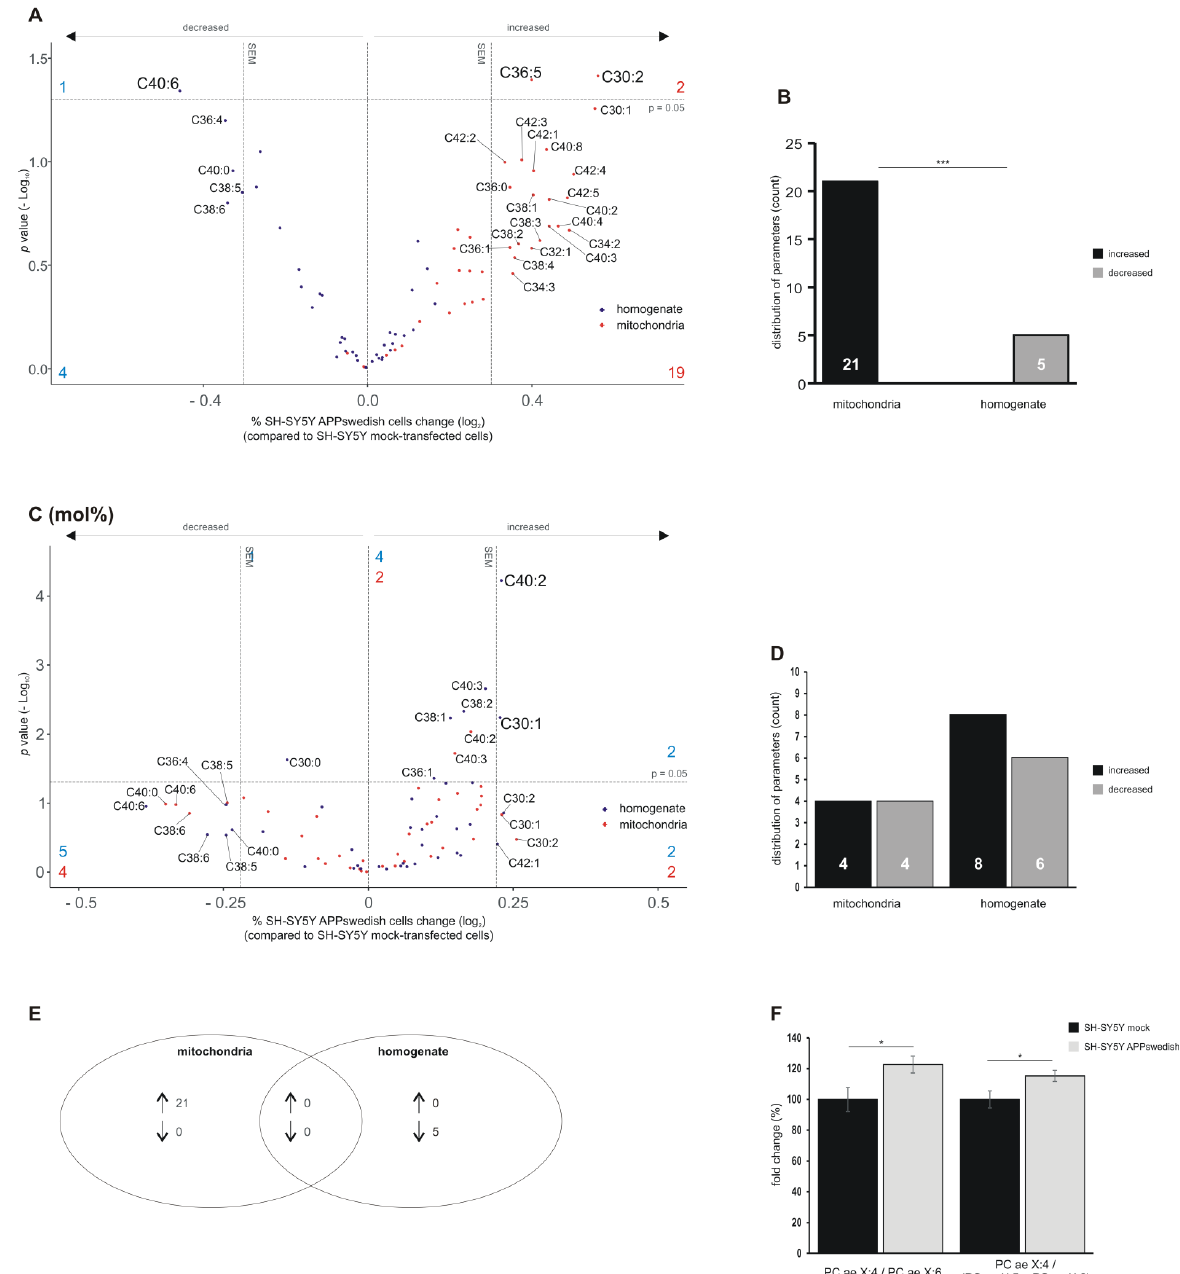
Figure 4. Changed phosphatidylcholine-plasmalogens (PCae) levels in homogenates and mitochondria of SH-SY5Y APPswedish cells in comparison to mock-transfected SH-SY5Y cells, respectively. ( A , B ) The fold changes of single PCae species in homogenates and mitochondria are shown as volcano plots and the corresponding distribution analysis is shown in a bar chart on the right. ( C , D ) The effects of single PCae species independent of PCae lipid class effect are presented as appropriate volcano plot and bar chart. Vertical dashed lines next to 0.0 represent the average SEM and the horizontal dashed line marks p = 0.05 in volcano plots. Statistical significance was calculated using Fisher’s exact test with *** p ≤ 0.001. ( E ) Venn diagram showing the number of exclusively changed as well as overlapping PCae species in mitochondria and homogenates in SH-SY5Y APPswedish cells compared to mock-transfected cells. Arrows indicate decreasing ( ↓ ) or increasing ( ↑ ) effects. ( F ) Fold changes of PCae X:4/PCae X:6- and PCae X:4/(PCae X:5 + PCae X:6) ratios, representing the ω3/ω6 relation, in mitochondria samples of SH-SY5Y APPswedish cells compared to SH-SY5Y mock-transfected cells. Statistical significance was calculated using two-tailed Student’s t -test with * p ≤ 0.05.